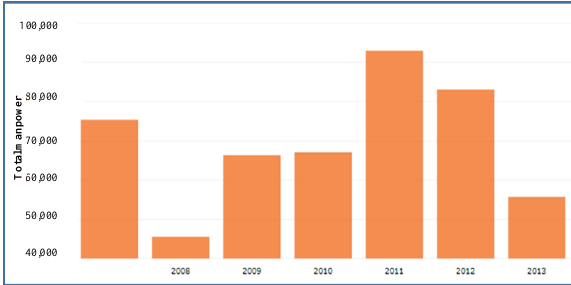
Figure 7. Number of workers in the industrial sector in Pemalang (Katadata team, 2016)